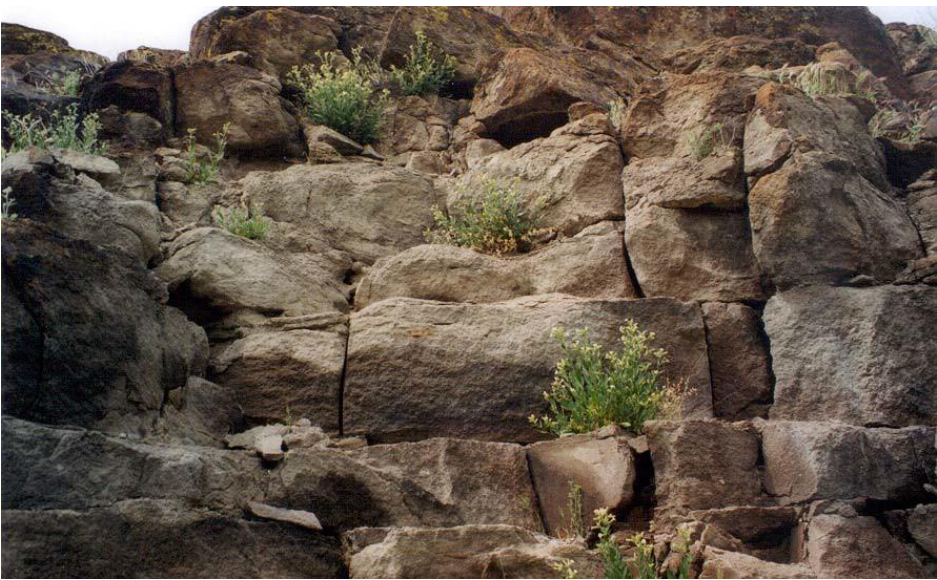
Figure 12. Koapi (Indian tobacco, Nicotiana trigonophylla ) growing out of the Black Butte cliff face (Source: Stoffle).